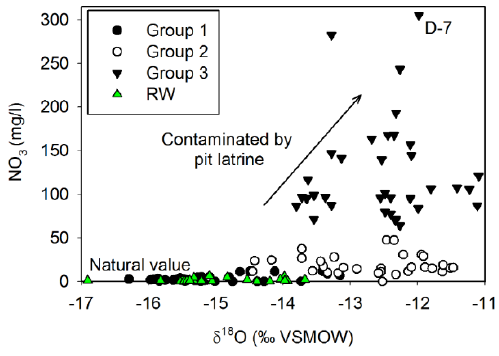
Figure 10. Identification of source areas of groundwater contamination based on a plot of NO 3 vs. δ 18 O.